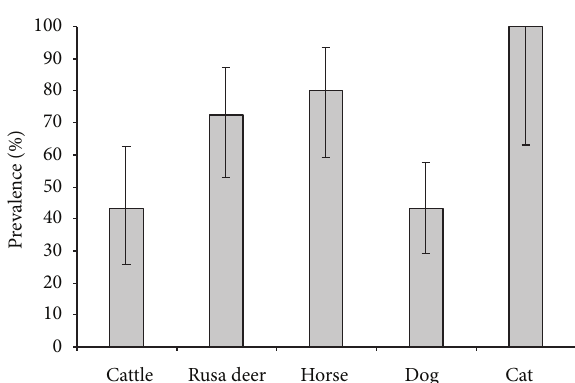
Figure 1: Percentage of positive samples for leptospirosis (MAT), according to species. Error bars indicate 95% confidence